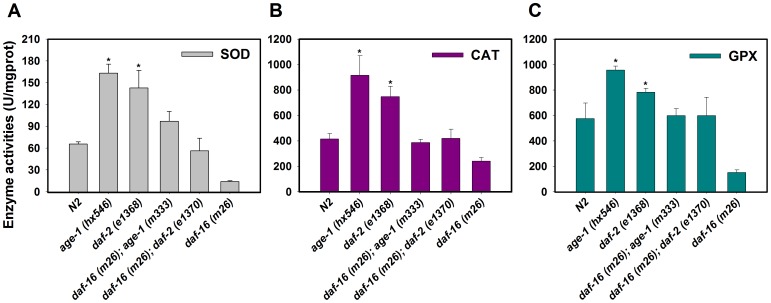
Antioxidant enzymes in daf-2, and age-1 mutants.(A) SOD activity in wild-type and daf-2, age-1, daf-16;daf-2, daf-16;age-1, daf-16 mutants. (B) CAT activity in these six strains. (C) GPX activity in these six strains. Values are presented as the means ±SE (n = 3) in U g−1 Pr. *P<0.05, **P<0.01 versus respective controls analyzed by t-test.